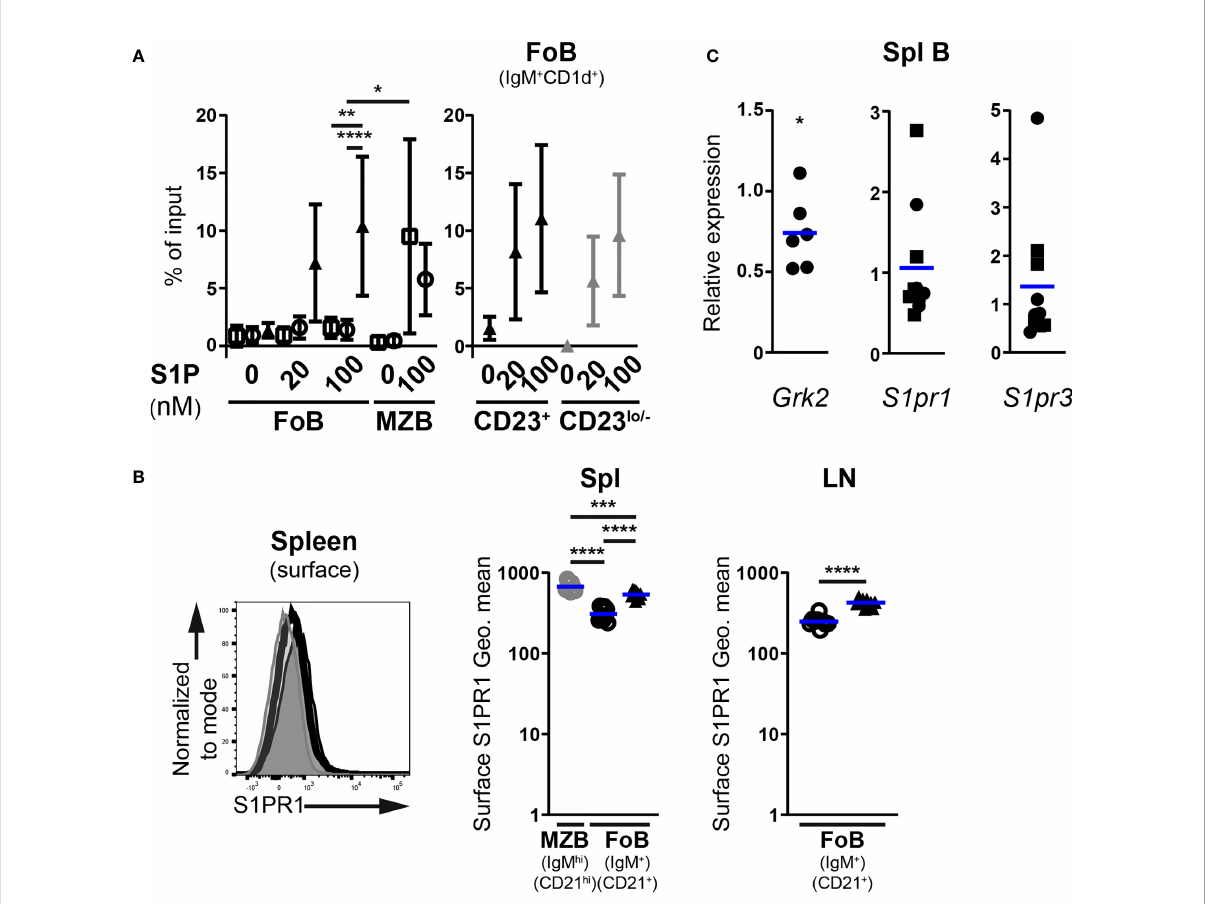
FIGURE 7 Enhanced S1P-mediated chemotaxis of follicular B cells upon inactivation of the miR-142 locus. (A) In vitro migration of splenic IgM + CD1d + follicular (FoB) and IgM hi CD1d hi marginal zone (MZB) CD19 + B220 + CD93 – mature B cells, as well as CD23 + and CD23 lo/ – mutant Fo B cells from Mb1-cre – ( □ ), Mb1-cre + ( ○ ) and Mb1-cre + miR-142 fl ( ▲ ) mice in response to 20 and 100 nM sphingosine-1-phosphate (S1P) ( n = 3-9 per group, cumulative of 11 independent experiments). B cells were detected in fl ow cytometry. Cells that migrated to the bottom chamber of the transwell after 3h are given as proportions of the speci fi c B population in the input splenocytes (% of input). (B) Left: Flow cytometry of S1PR1 surface levels on splenic IgM + CD21 + Fo B cells (thick black histogram) from Mb1-cre + miR-142 fl mice, as well as on splenic IgM + CD21 + Fo (light grey- fi lled histogram) and IgM hi CD21 hi MZ (dark grey- fi lled histogram) B cells from Mb1-cre + control animals. Right: Geometric means (Geo. Mean) of surface S1PR1 on Fo (black) and MZ (grey) B cells from spleens (Spl) and lymph nodes (LN) of Mb1-cre + ( ○ ) and Mb1-cre + miR-142 fl ( ▲ ) mice. n = 9-10 per group in 6 independent experiments. (C) Real-time PCR of S1pr1 , S1pr3 and Grk2 mRNA levels in magnetically-puri fi ed splenic B cells from Mb1-cre + miR-142 fl mice. Normalized to Hprt transcript levels and to their respective expression in Mb1-cre – ( n=5 , ◼ ) and Mb1-cre + ( n=5-6 , ● ) controls. Pooled from 15 independent pairs of mice. (A) Symbols and vertical lines indicate the means and standard deviations respectively. (B, C) Horizontal blue lines signify the means. Each symbol represents one mouse (B) or a ratio between a pair of control and mutant animals (C) . *, P ≤ 0.05; **, P ≤ 0.01; ***, P ≤ 0.001; ****, P ≤ 0.0001 by one-way ANOVA (A, B) , Student ’ s t test (B) and one sample t test (C) . (A) Data on Fo B cell migration in the absence of treatment from 4 Mb1-cre – , 6 Mb1-cre + and 7 Mb1-cre + miR-142 fl mice are shared with the experiments in Figure 4. Samples excluded: One Mb1-cre + Fo B cells (both 20 and 100 nM S1P) as well as one Mb1-cre – and